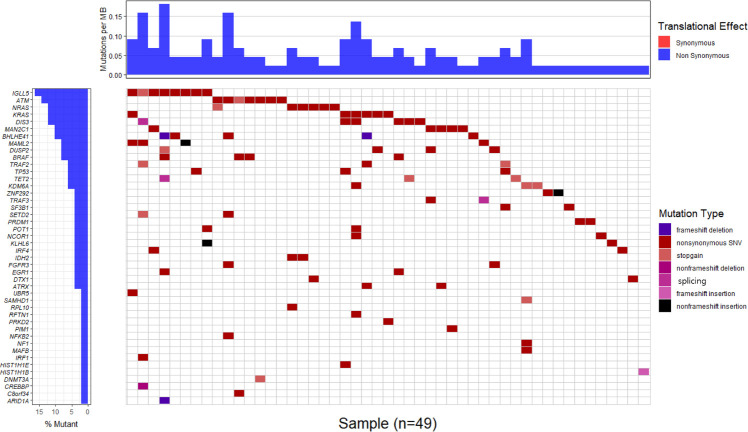
Frequency and distribution of somatic mutations in patients with NDMM.Mutation burden per megabase (Mb) in tumor are represented (upper) and mutated genes are ranked by mutant frequency (lower). The heatmap showed individual mutations in patient samples, color-coded by type of mutation. Genes with significant somatic mutations (pathogenic, likely pathogenic, and variants of unknown significance by ACMG guideline) are represented.